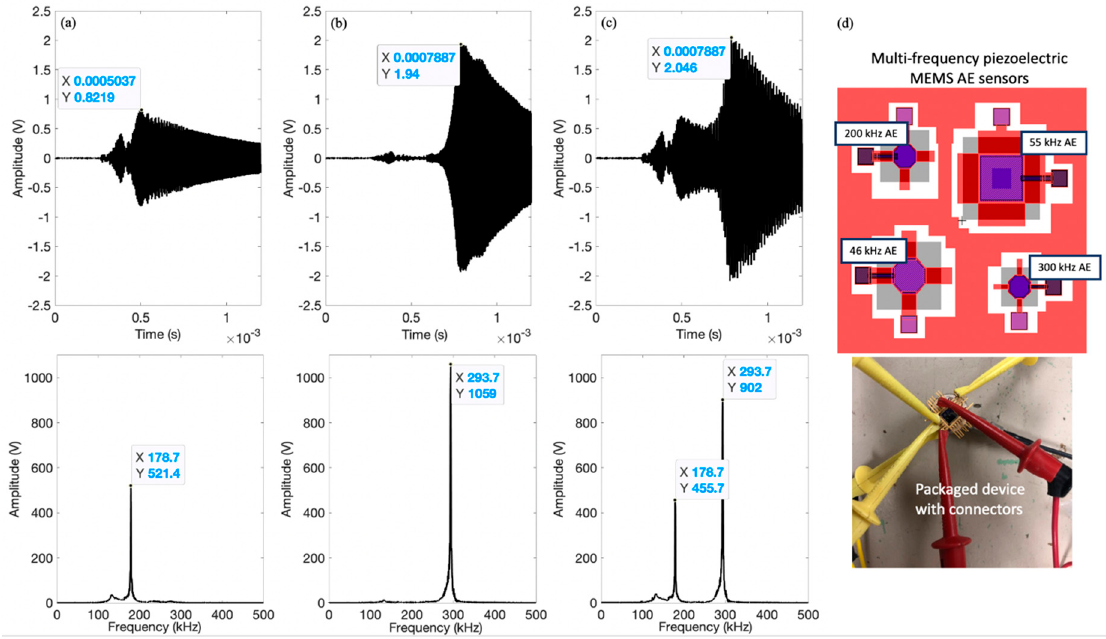
Figure 8. Single channel, multifrequency, piezoelectric MEMS AE sensor for boosting the sensitivity, ( a ) connecting only 200 kHz sensor in time and frequency domains, ( b ) connecting only 300 kHz sensor in time and frequency domains, ( c ) series connection of 200 kHz + 300 kHz sensors in time and frequency domains, ( d ) the layout of MEMS device and the packaged configuration.